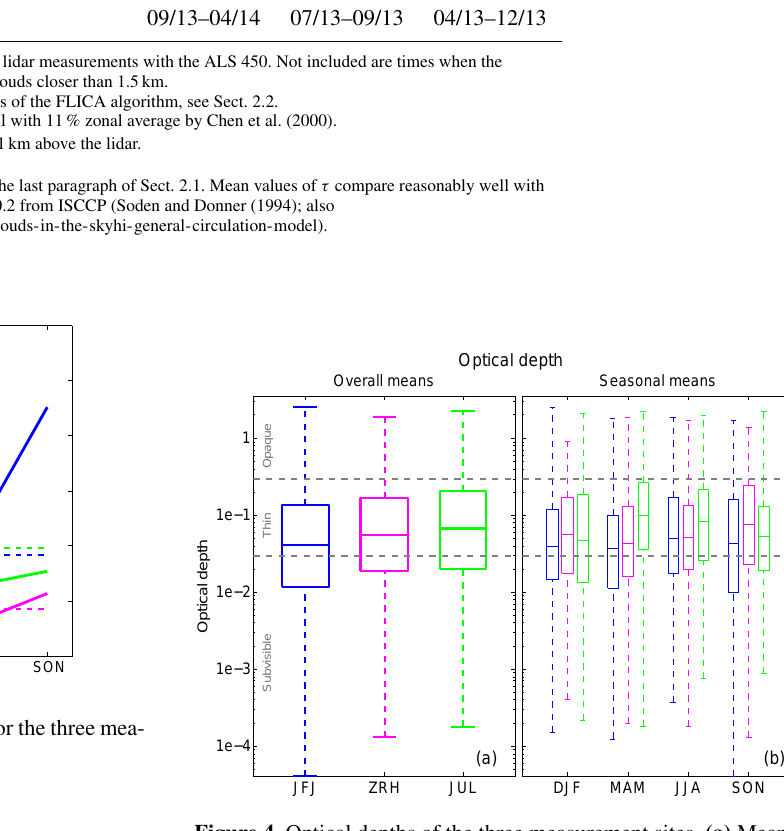
Subvisible cirrus ( τ < 0 . 03) in %